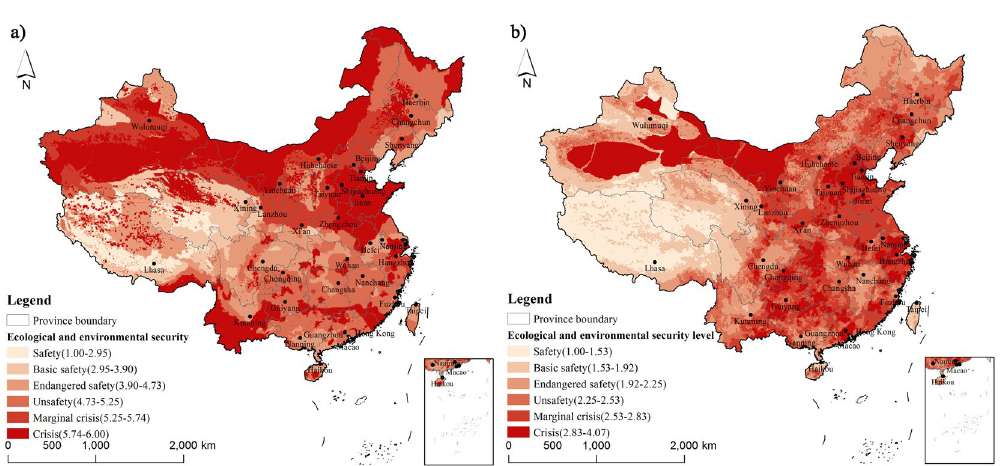
Figure 2. Spatial destitution of ecological and environmental security in China ( a ) veto aggregation method in around 2010; ( b ) balanced aggregation method in around 2010. Maps were generated by ArcGIS version 10.1.0 (http://www.esri.com/software/arcgis). Note: Non-evaluation areas, which were at the extreme of degradation and cannot support human survival and development, did not need to be evaluated and were labeled as the “crisis”